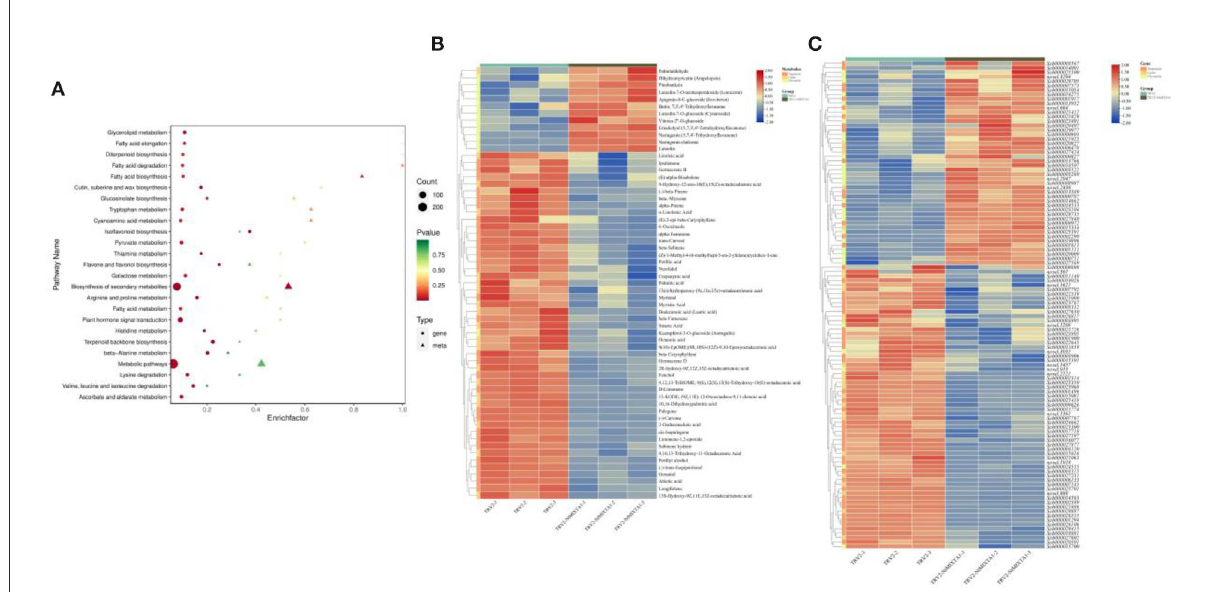
FIGURE5 KEGG enrichment of top 50 pathways of combined analysis (A) . Heatmap of DEMs involving terpenoids, flavonoids, and lipids (B) and related gene expression (C) .